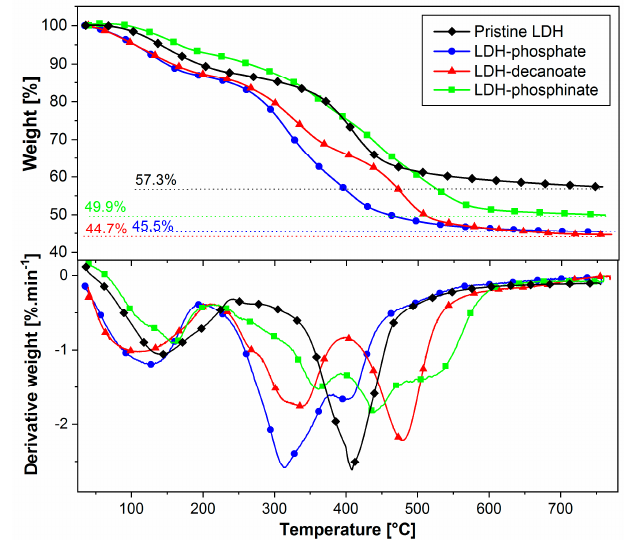
Figure 3. Thermogravimetric and derivative weight curves of pristine LDH,